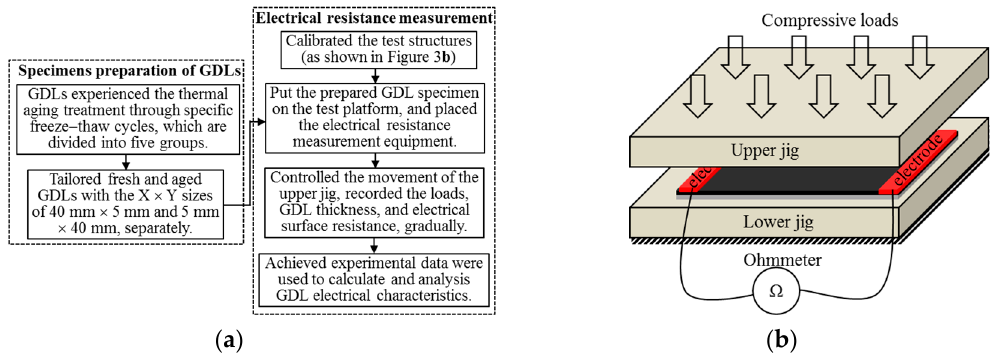
Figure 3. Schematics of the in ‐ plane electrical resistance measurement of the commercial GDL: ( a ) Test procedure; ( b ) test structure.